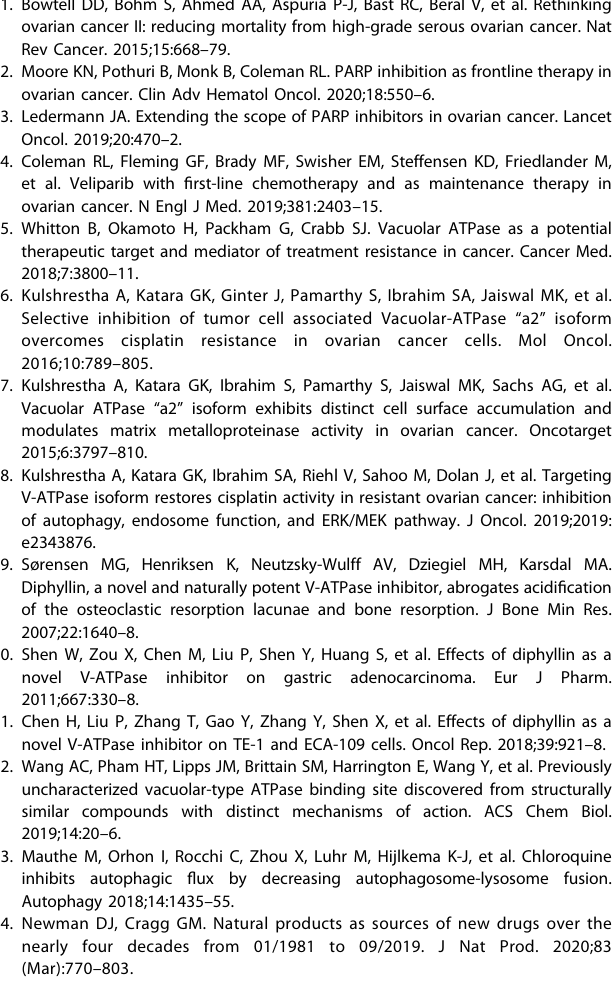
according to the manufacturer ’ s protocol. Samples were normalized to the housekeeping gene, GAPDH. qRT-PCR primer sequences are mentioned in Table 3. Cell viability assay Cells were seeded in 96-well, clear, fl at-bottomed plates at 2500 to 5000 cells per well, depending on the cell line, and allowed to attach overnight. Compounds suspended in DMSO were diluted to fi nal concentrations and added to the cells. The fi nal vehicle concentration was 0.25% to achieve a wide dose range. Cells were incubated for 24, 48, or 72 h. Cellular protein